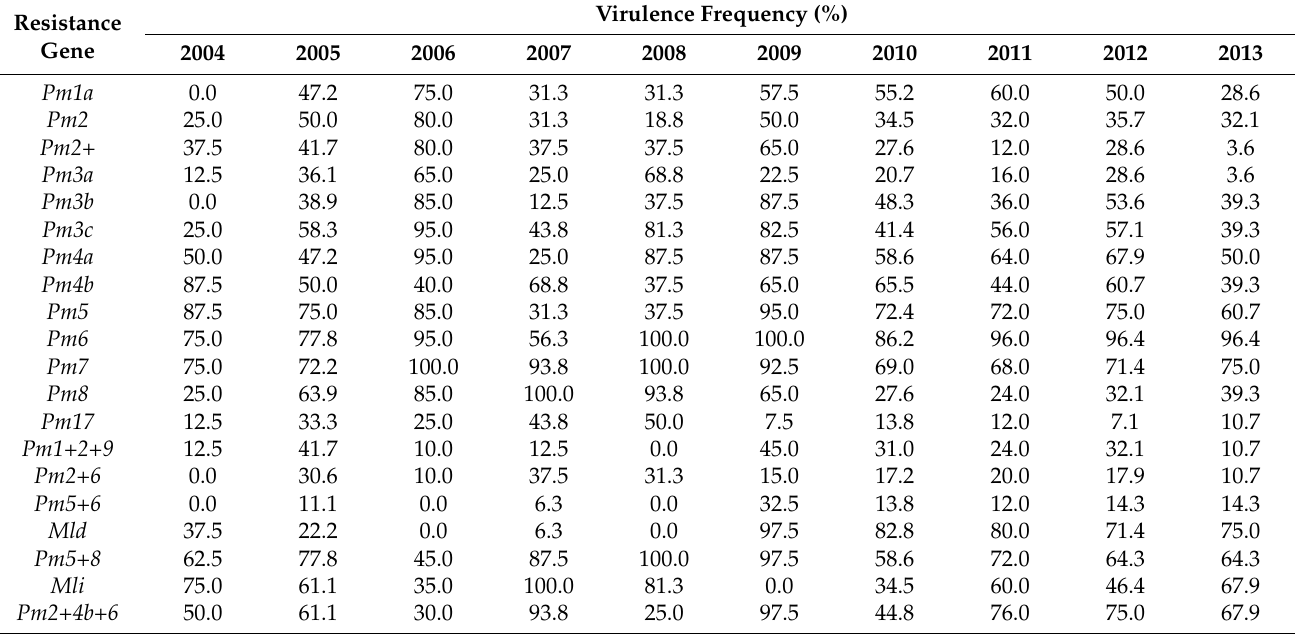
Table 5. Virulence frequencies of Blumeria graminis f. sp. tritici genes in the period